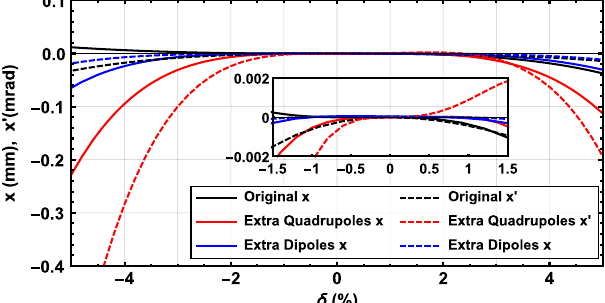
FIG. 9. Horizontal momentum acceptance of the original, fixed design with chromatic corrections (black), variable with extra quadrupoles (red) and variable with extra dipole (blue) solutions.